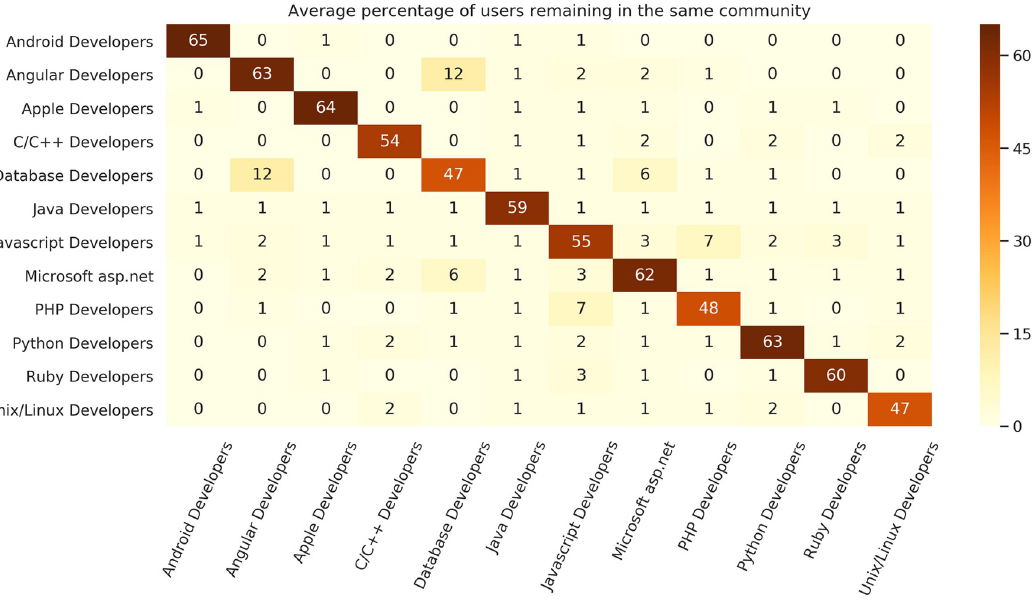
Fig 9. Heat map of year-to-year pairwise similarity of community membership. The heat map displays the average percentage overlap of users belonging to each pair of communities in consecutive years between 2008 and 2020. Diagonal entries indicate self- similarity and community persistence. Off-diagonal entries indicate flows between